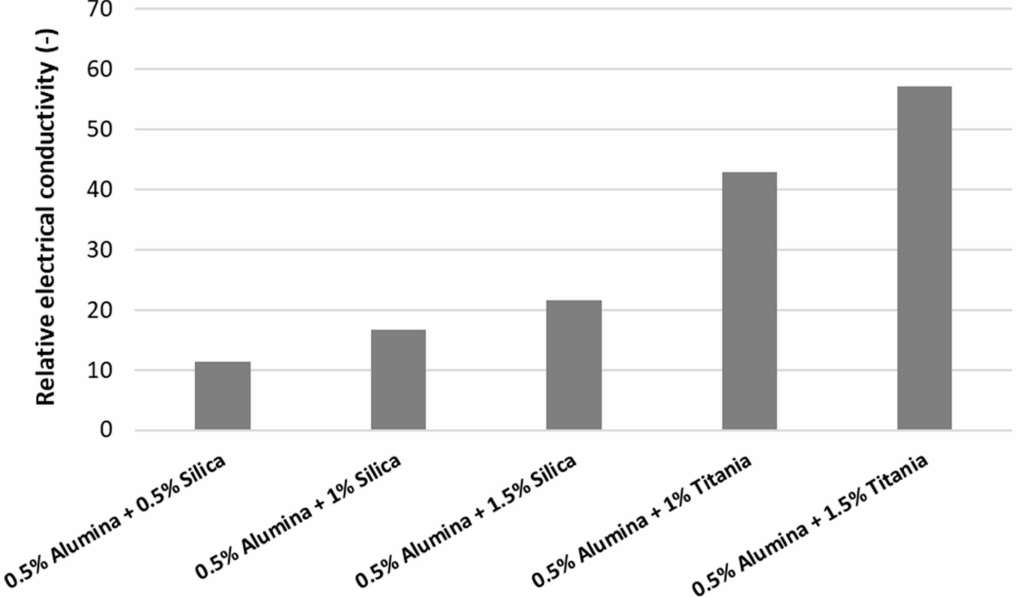
Figure 2. Experimental results on hybrid nanofluids at ambient